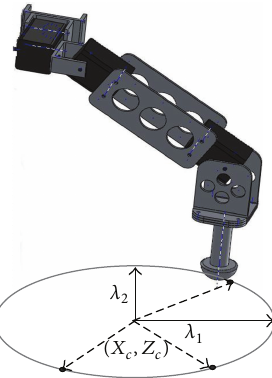
Figure 3: Ellipse trajectory of